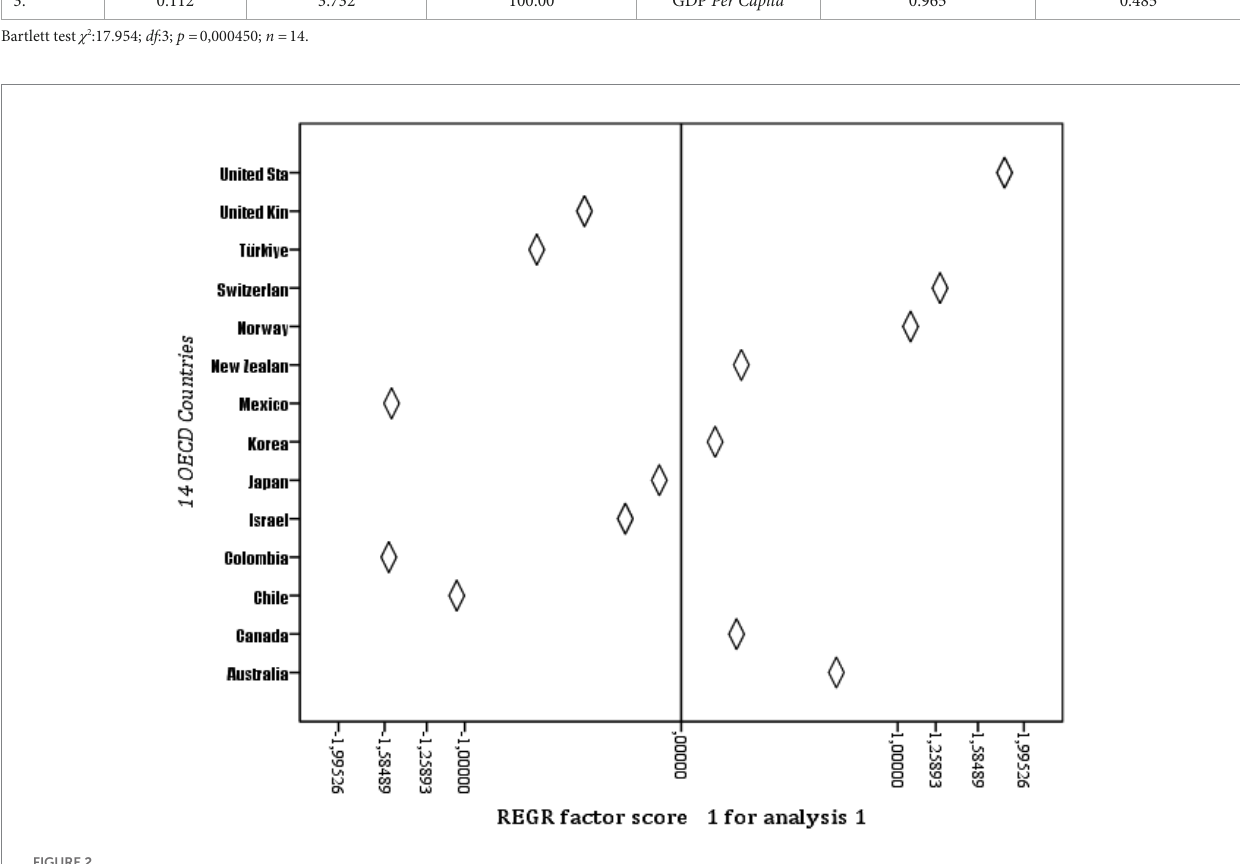
TABLE 3 Distances of variables according to Factor 1 and priority